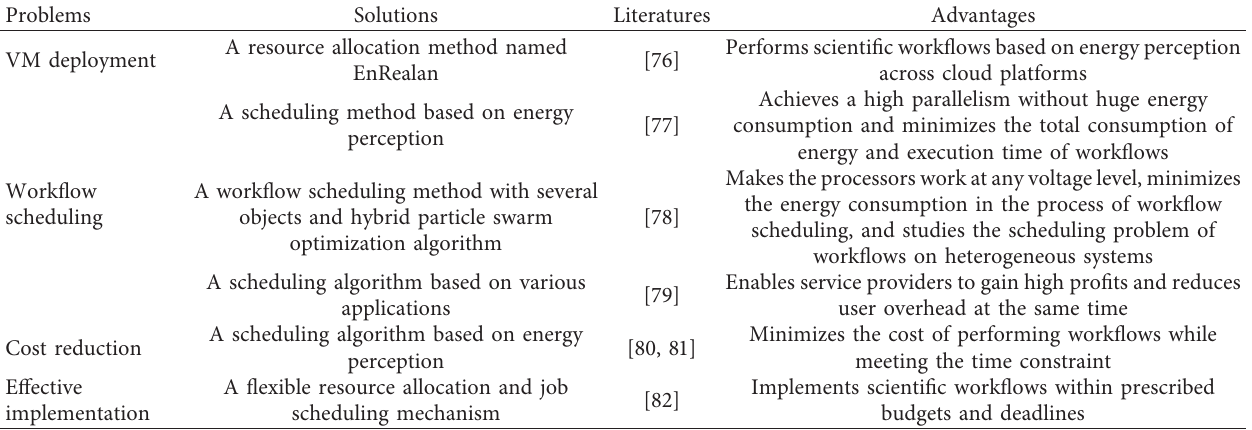
Table 5: Work summary of scientific workflow execution in cloud computing.